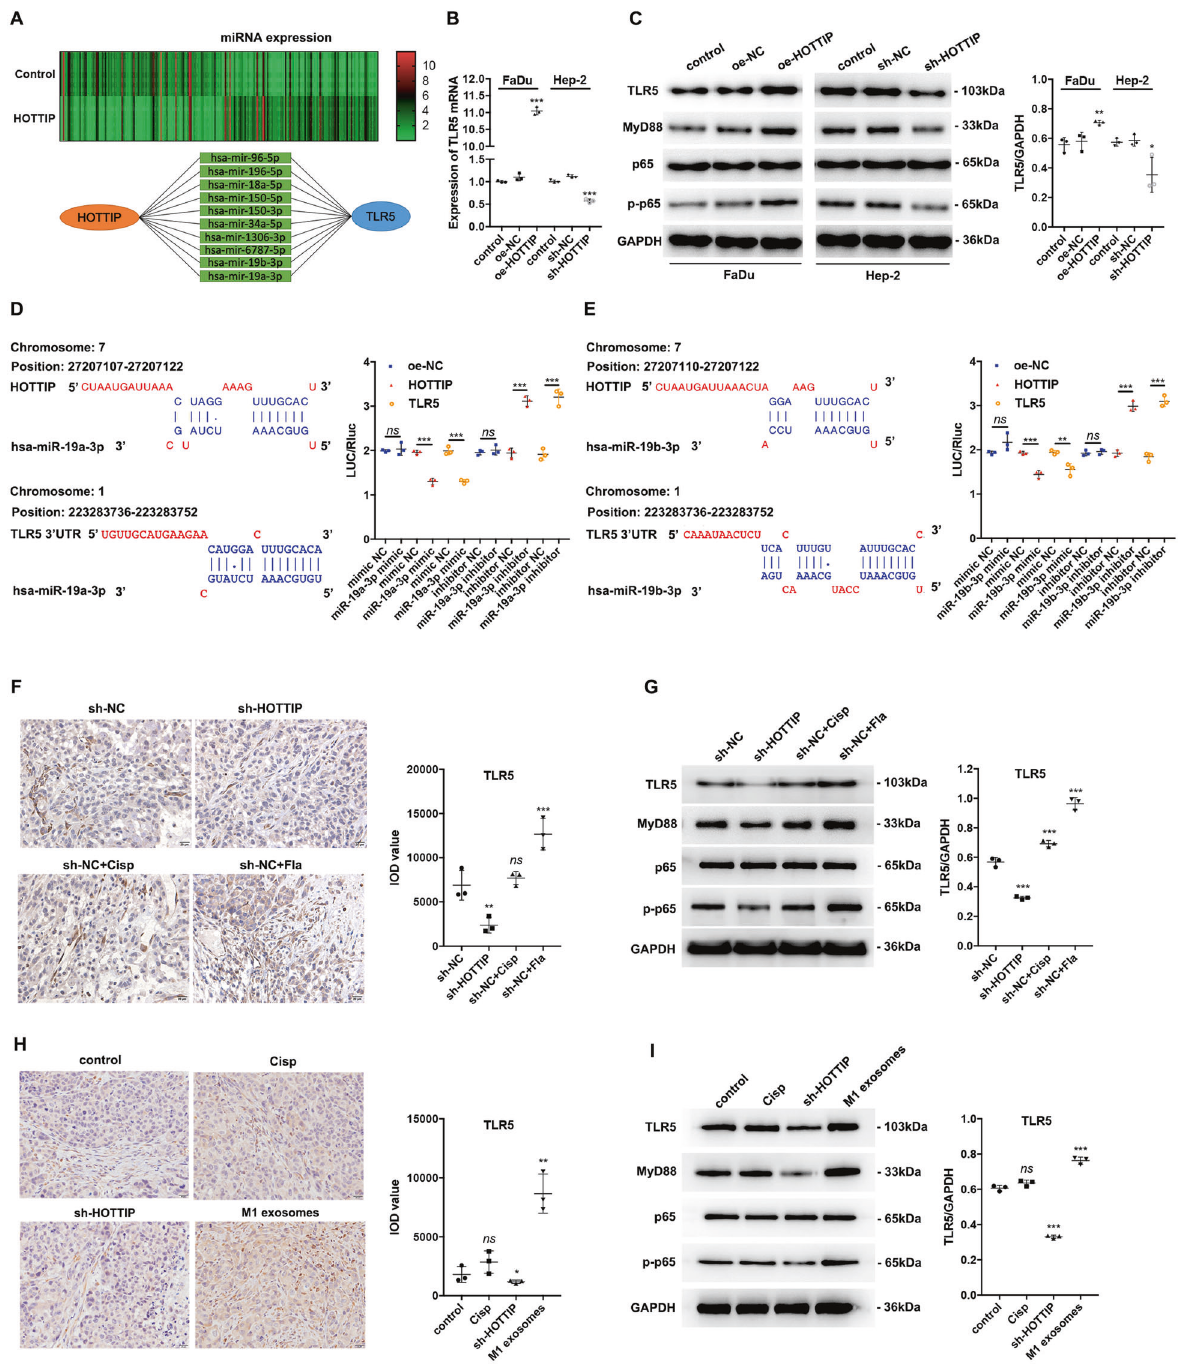
Fig. 5 HOTTIP and M1 exosomes upregulate the TLR5/NF- κ B signaling pathway by competitively sponging miR-19a-3p and miR-19b-3p. A High-level Agilent miRNA chip was established using HOTTIP-overexpressed FaDu-derived exosomes. The expression of 5000 miRNAs was tested, of which 257 miRNAs were signi fi cantly downregulated (upper panel). Ten potential ceRNA networks were predicted by the miRWalk 2.0 database (lower panel). B RT-qPCR detected the relative expression of TLR5 mRNA. Overexpression of HOTTIP upregulated TLR5 mRNA expression while knockdown of HOTTIP downregulated it ( n = 3). C Western blot assay of a key protein (TLR5, MyD88, p65 and p-p65) in TLR5/ NF- κ B signaling pathway. Overexpression of HOTTIP upregulated TLR5 protein expression while knockdown of HOTTIP downregulated it ( n = 3). The predicted binding site between HOTTIP, miR ‐ 19a-3p ( D )/miR ‐ 19b-3p ( E ) and TLR5 mRNA. HEK293T cells were transfected with miR-19a/ b-3p mimic or inhibitor. Relative luciferase activity (LUC/Rluc) was detected 48 h post interaction using dual luciferase assay. miR-19a/b-3p mimic decreased LUC/Rluc while miR-19a/b-3p inhibitor increased it ( n = 3). IHC detected TLR5 protein expression, which suggested that knockdown of HOTTIP ( F ) downregulated while M1 exosomes ( H ) upregulated TLR5 expression ( n = 3). Western blot assay of a key protein in TLR5/NF- κ B signaling pathway. Knockdown of HOTTIP ( G ) downregulated while M1 exosomes ( I ) upregulated TLR5 expression ( n = 3). Data are presented as mean ± SD. Results were analyzed by One-way ANOVA with a post hoc test. Signi fi cance: * P < 0.05, ** P < 0.01, *** P < 0.001.